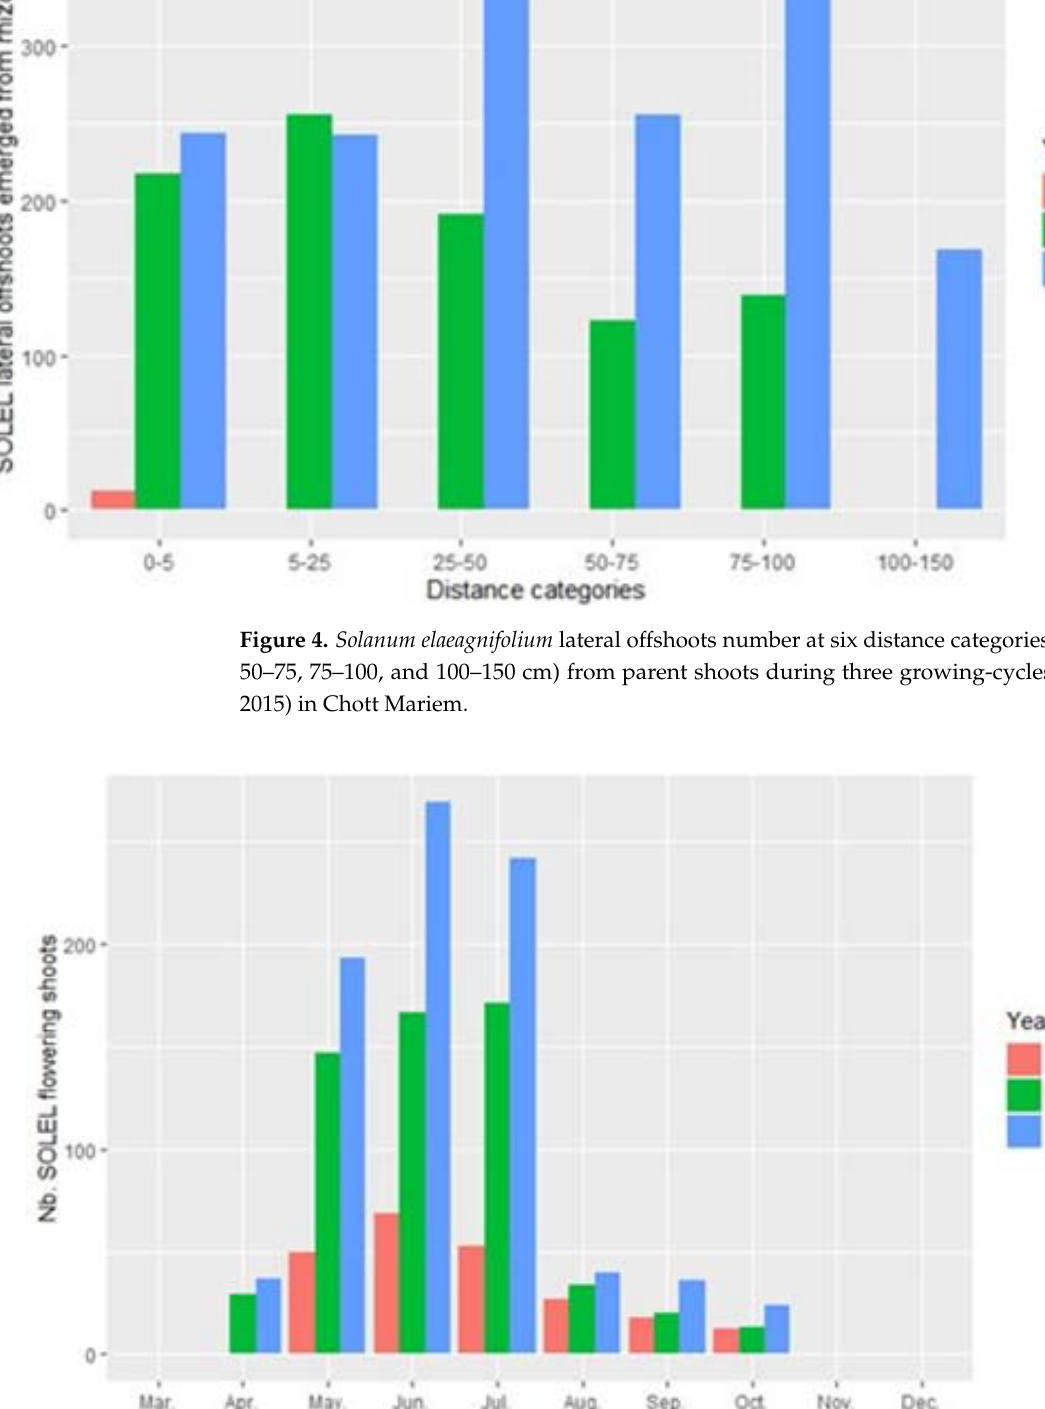
Figure 4. Solanum elaeagnifolium lateral offshoots number at six distance categories (0–5, 5–25, 25–50, 50–75, 75–100, and 100–150 cm) from parent shoots during three growing-cycles (2013, 2014, and 2015) in Chott Mariem.